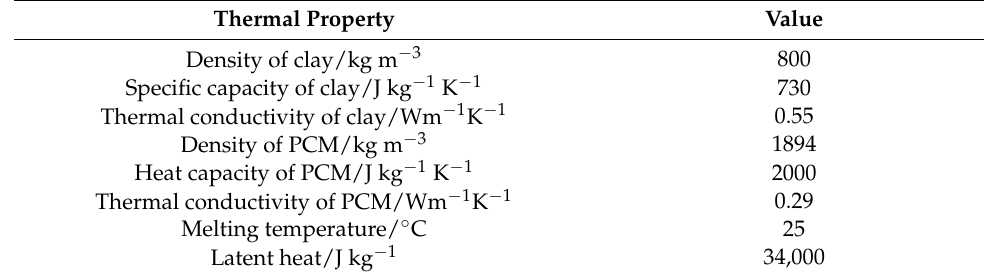
Table 2. Thermal properties of ingredients of TSTBs employed in numerical